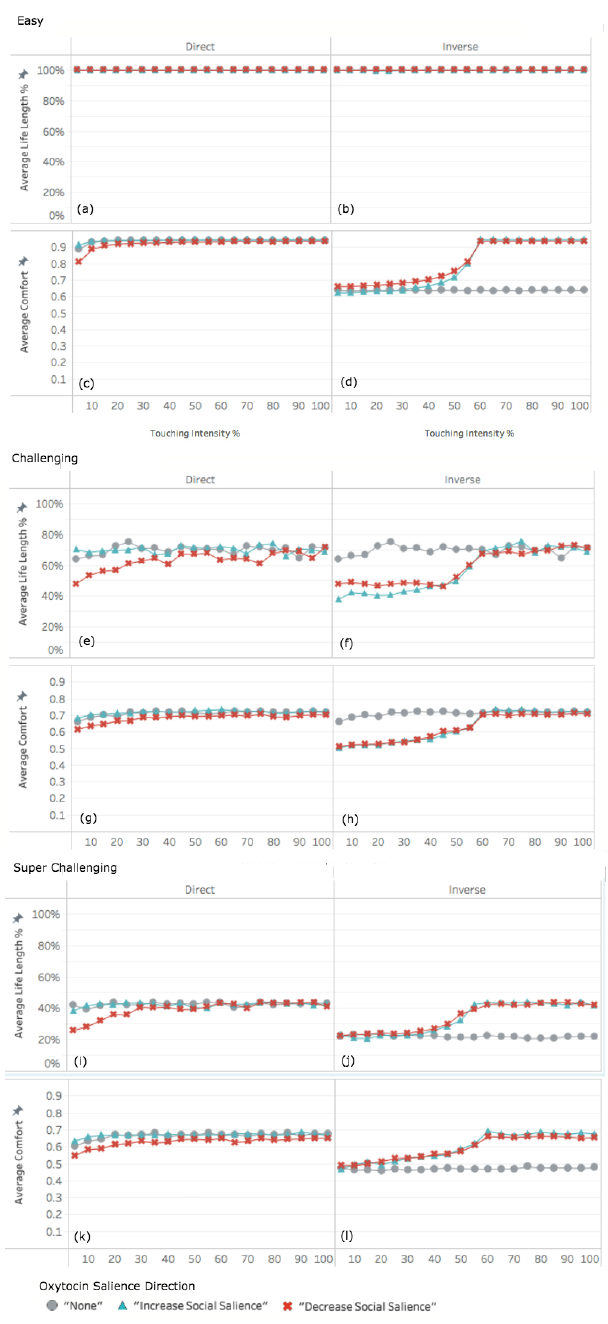
Figure 4. Summary of results for Experiment 2. Average Life Length and Comfort Levels across all touchingIntensity values with modulation of internal Oxytocin levels. Direct modulation of touchingIntensity are all graphs to the left, Inverse modulation of touchingIntensity are all graphs to the right. ( a ) Average life length across Easy (E) worlds + Direct (D) modulation. ( b ) Average life length across Easy (E) worlds + Inverse (I) modulation. ( c ) Average comfort levels across Easy (E) worlds + Direct (D) modulation. ( d ) Average comfort levels across Easy (E) worlds + Inverse (I) modulation. ( e – h ) As ( a – d ), for Challenging world conditions. ( i – l ) As ( a – d ), for Super Challenging world